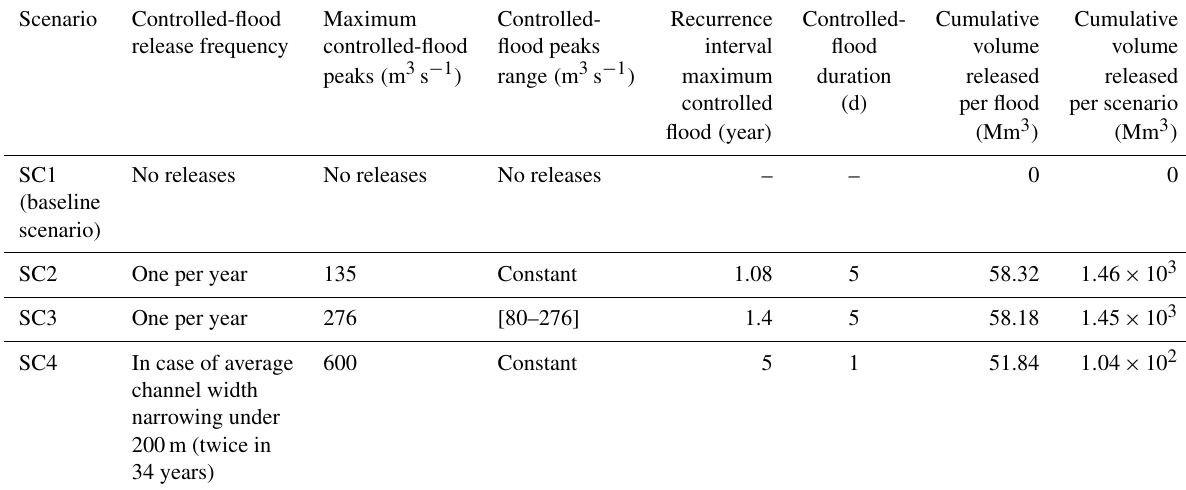
Table 2. Main hydrological characteristics of the four